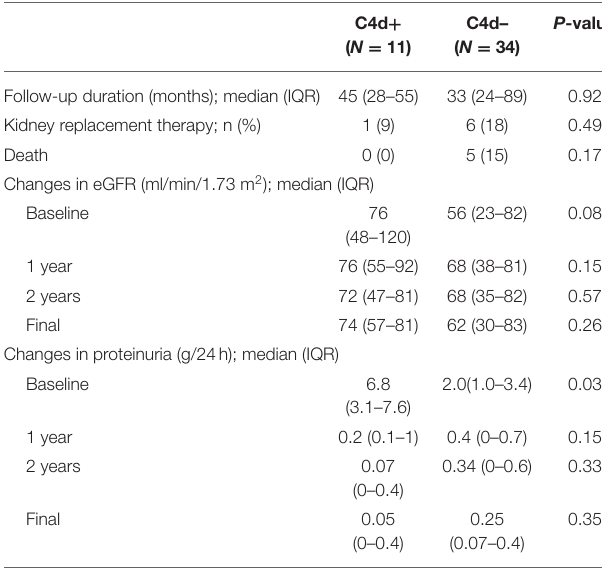
TABLE 2 | Follow-up according to the presence or absence of C4d glomerular deposits.